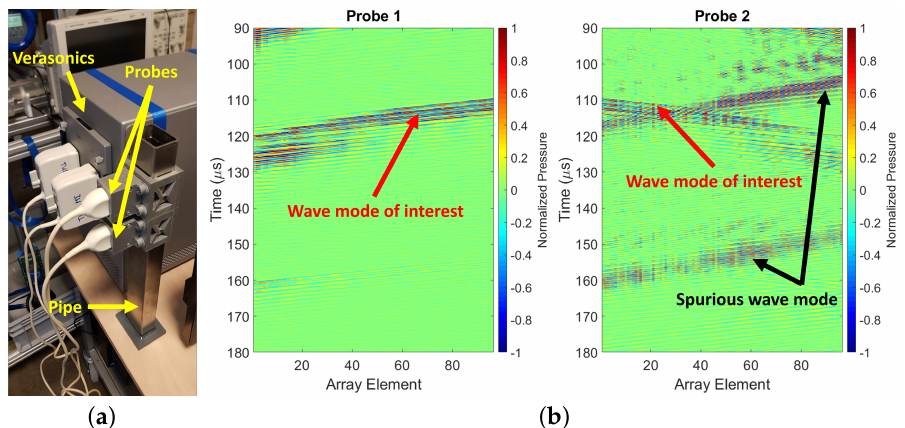
Figure 8. ( a ) Setup to carry out measurements on which to test the proposed algorithm. The probes are two P4 − 1 transducer arrays clamp-on on the outside of a square stainless steel pipe filled with water. ( b ) Typical measured wavefield. Measurements were carried out at zero-flow conditions.